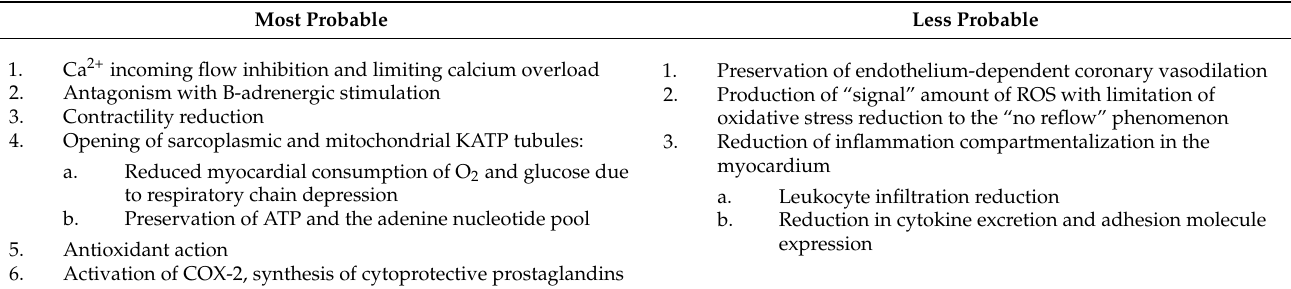
Table 2. Mechanisms of NO-mediated cardiac